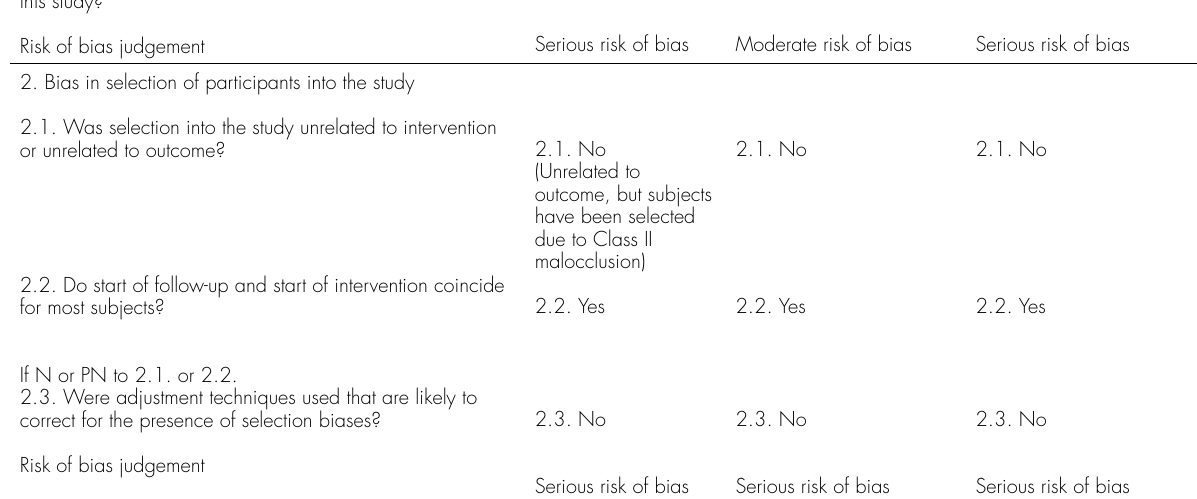
Risk of bias assessment (cohort-type studies)